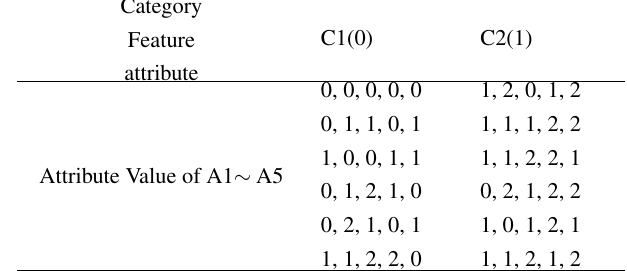
Table 4 Training Set for Discrete Processing of Characteristic Attributes Category